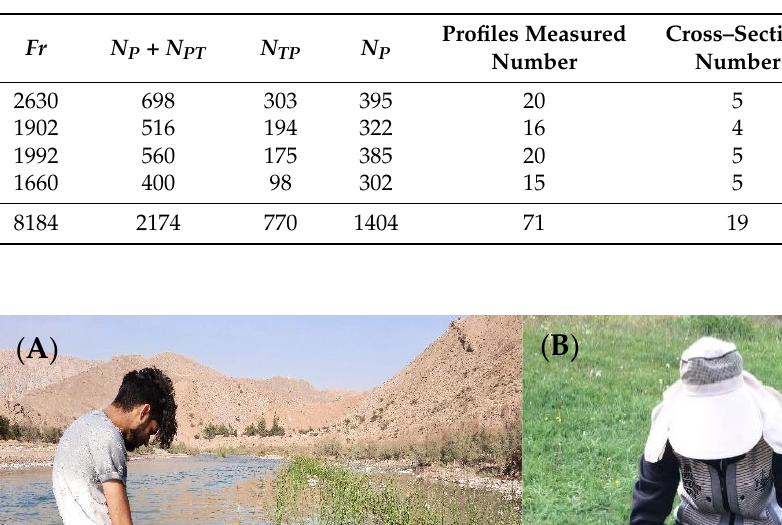
Figure 6. ( A ) Sampling of riverbed sediment, ( B ) measurement of riverbed sediments.